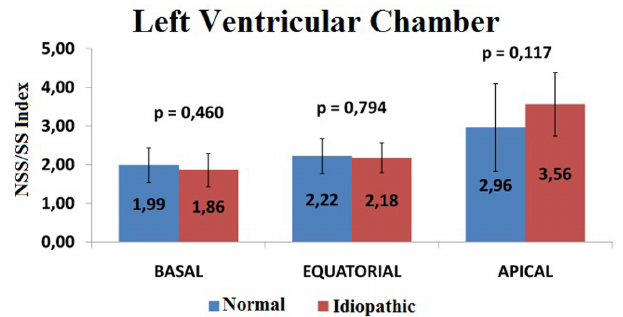
Fig. 3 - Comparison of mean values of the NSS/SS ratios from basal, equatorial and apical regions of the left ventricular chamber in both